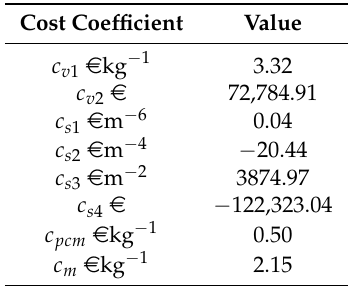
Table 3. Cost coefficients of the approximation functions of Equations (15) and